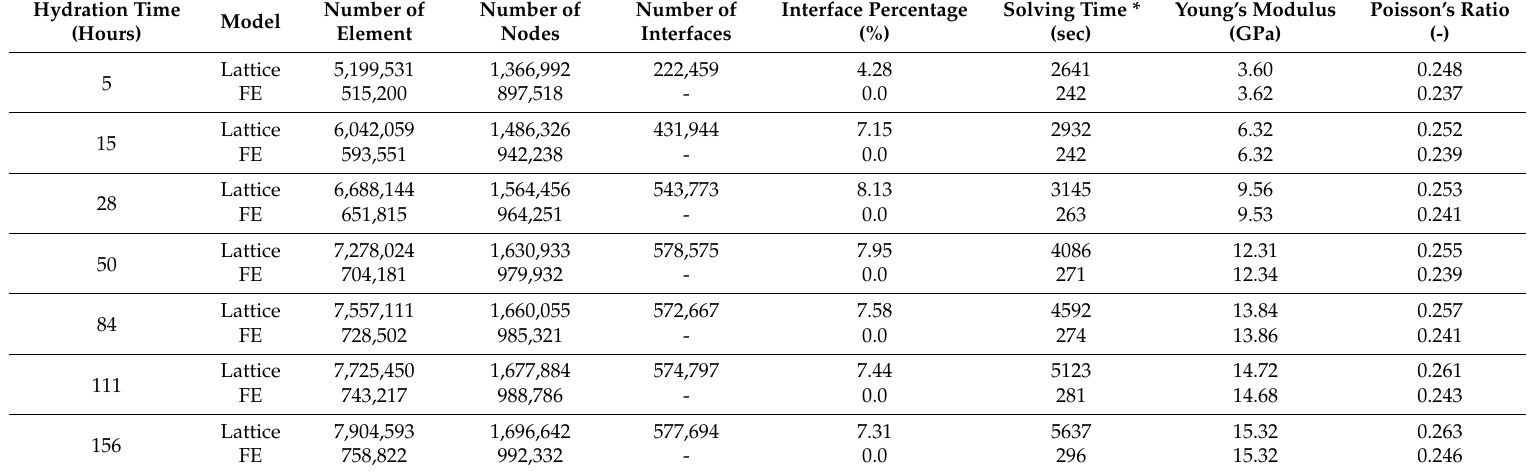
Table 5. Computational details for the lattice and Finite Element Method (FEM) models for w / c = 0.40.